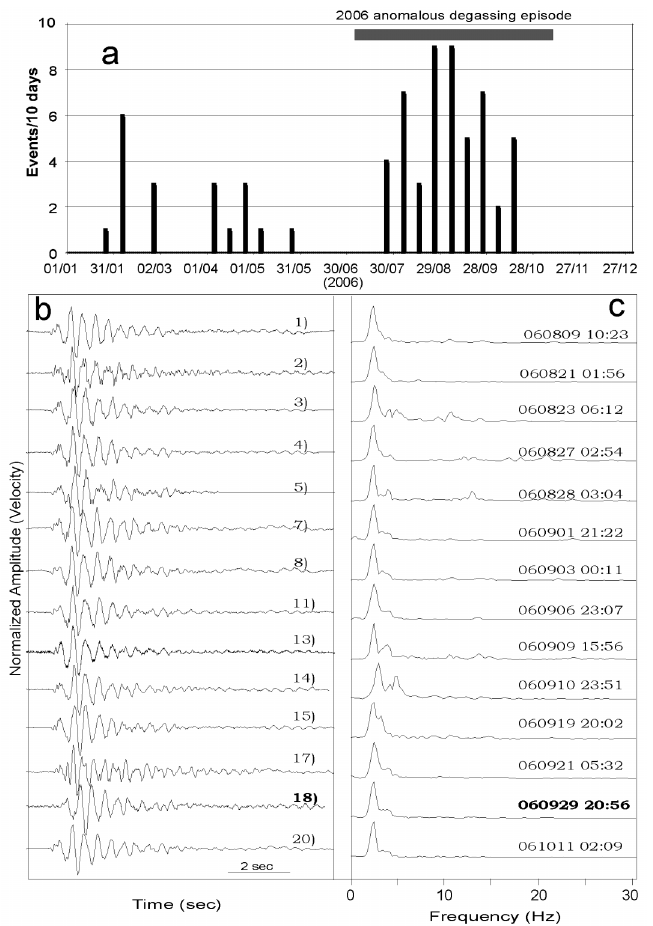
Fig. 2 a-c. Occurrence of LP during 2006 (a), waveforms (b) and spectra (c) of the events analyzed (and relo- cated). Each event number is referred to tab.